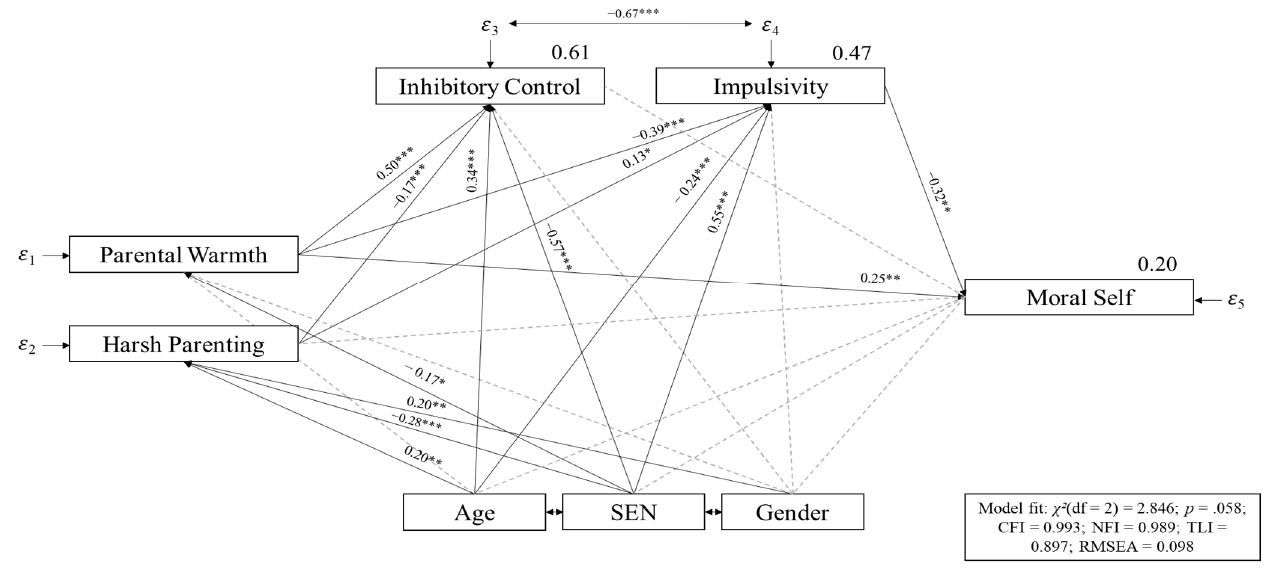
Figure 1. Path model. Note. * p < 0.05; ** p < 0.01; *** p < 0.001; values above the variable names indicate explained variance; non-significant paths were marked with grey dashed lines, SEN = special educational needs in emotional–social development, gender was coded with girls = 1 and boys = 2; SEN was coded with 1 = without SEN and 2 = with SEN.